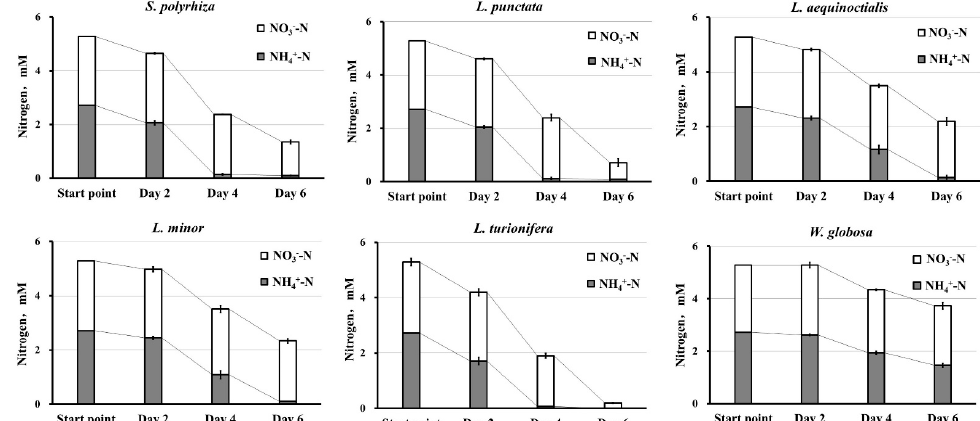
Figure 3. Relative dynamics of nitrate and ammonium uptake by duckweed species during six days of cultivation in medium supplied with equal amounts (2.5 mM) of NO (cid:2871)(cid:2879) and NH (cid:2872)(cid:2878) .